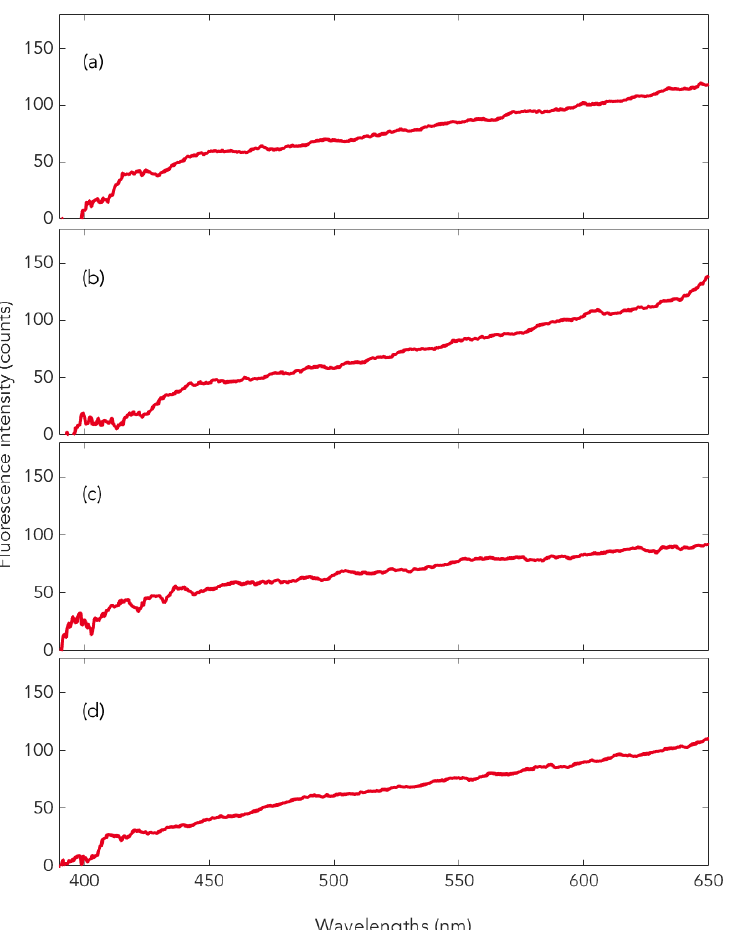
Figure 3. Representative measurements on different types of melanoma: ( a ) SSM, ( b ) NM, ( c ) ALM, and ( d ) choroidal melanoma, all measurements performed in histological specimen (FFPE). * Technical note: Fluorescent markers (e.g., surgical skin markers, dyes used for im- munohistological staining) can give rise to fluorescence interfering with the measurements and should be avoided. Nevertheless, spectra of such artifacts are recognized in the auto- matic evaluation of the fluorescence data and the corresponding tissue sample is removed from a diagnostic